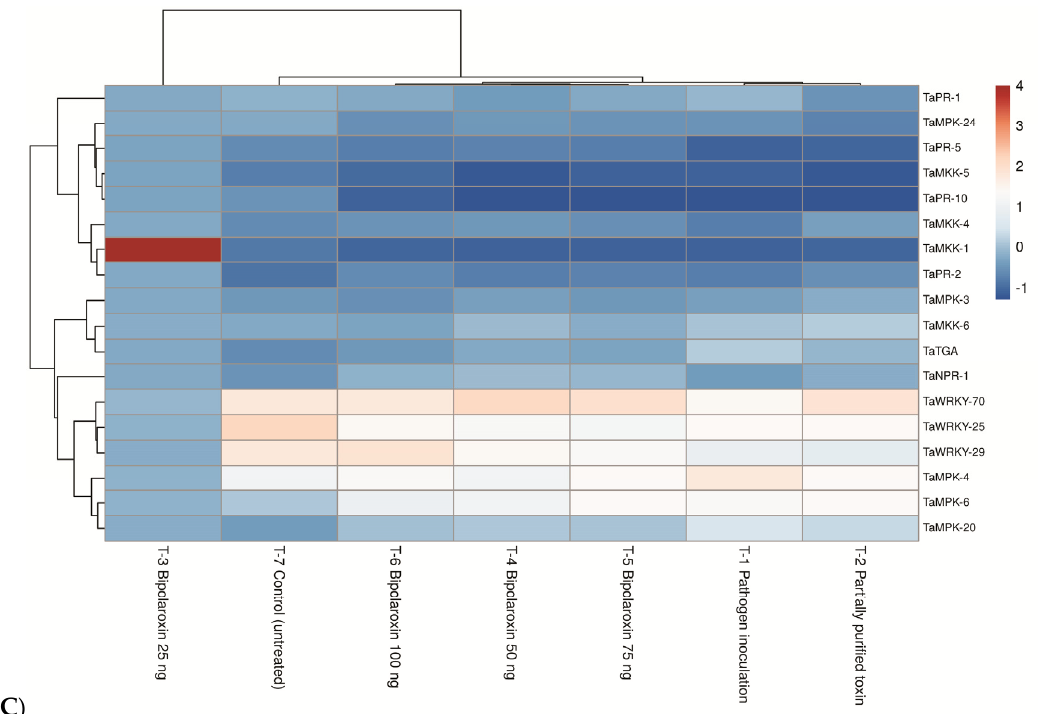
Figure 12. Expression profile of key genes of MKK/MAPK pathways in susceptible line, Agra Local ( A ) and resistant lines, Chinese Spring ( B ), and Chirya3 ( C ) under pathogen inoculation and infiltration of partially purified toxin obtained from B. sorokiniana as well as chemically synthesized Bipolaroxin at 7 days of inoculation/treatments under glasshouse conditions.